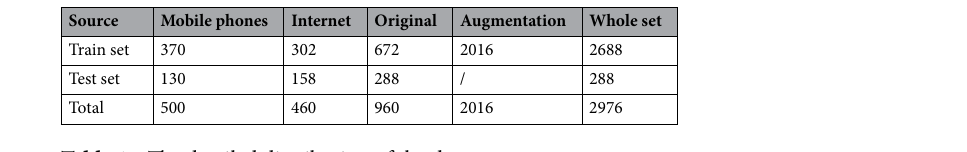
Table 1. The detailed distribution of the